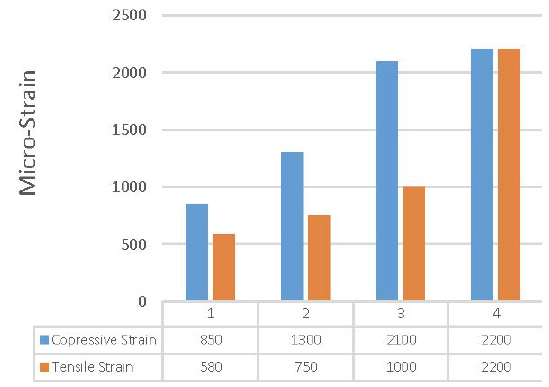
Figure 1: Adaption of skeletal system to strain or mechanical loads